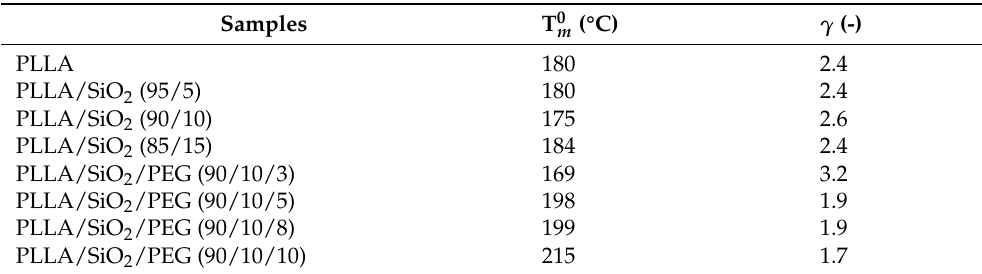
Table 6. Variation of T 0 m with SiO 2 and PEG content, as determined by the Hoffman–Weeks extrapo- lation